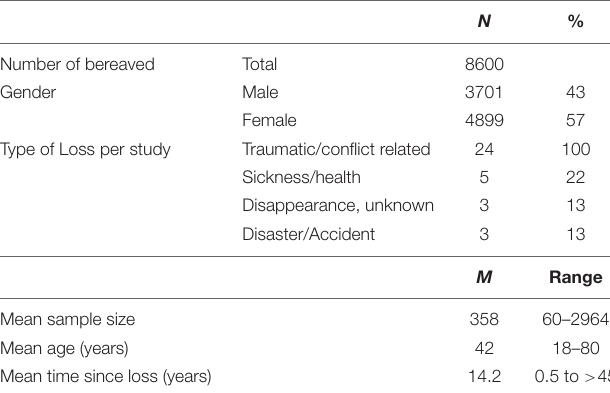
TABLE 1 | Demographic characteristics of study participants across 24 included